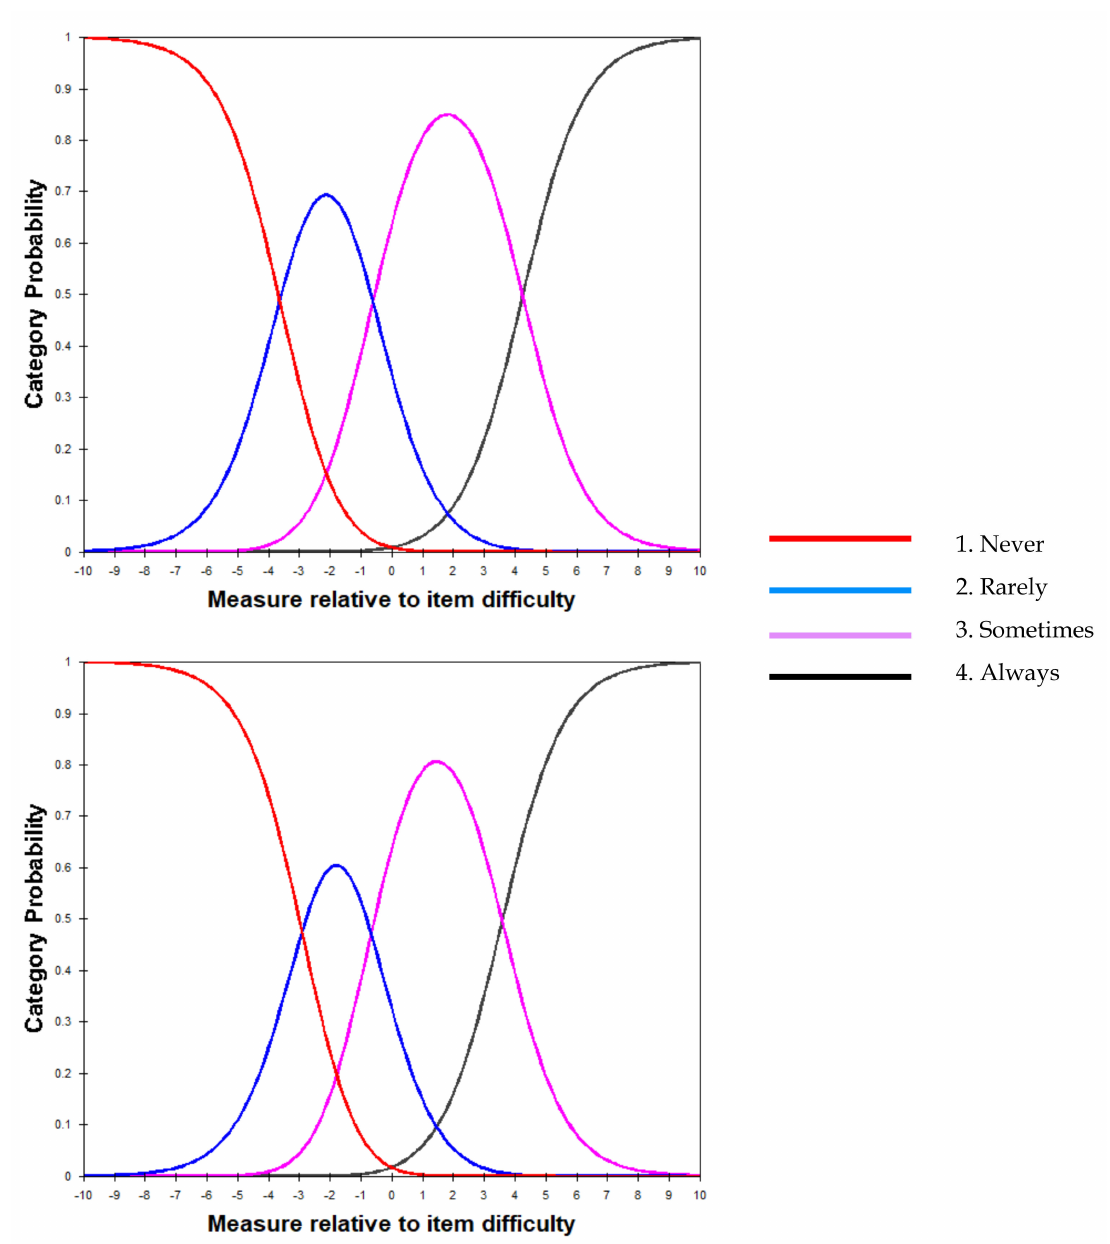
Figure 2. Graphic presentation of the probability of responses for each of the four ratings (top: associative play area; bottom: cooperative play